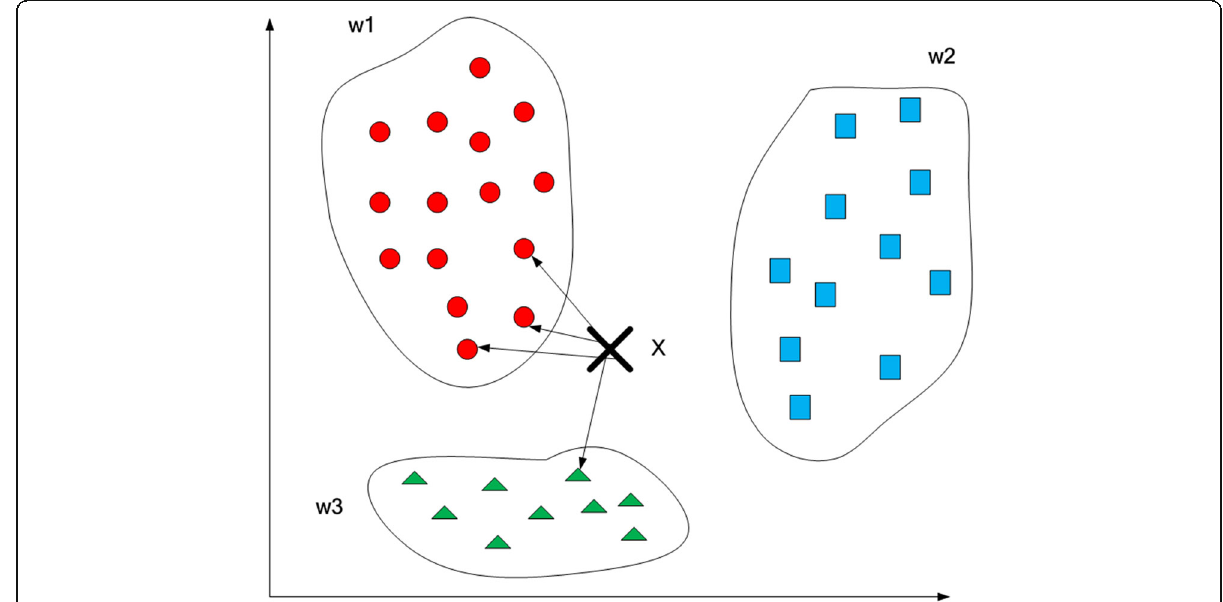
Fig. 7 Classification process of KNN classification